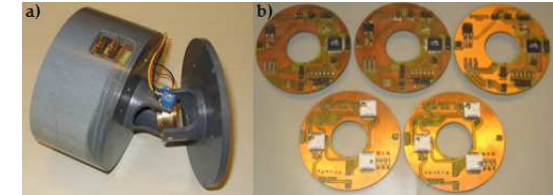
Figure 5: A segment of the snake. (a) Mechanically as- sembled snake segment. (b) Front and back of the electronic circuit boards for the 5 seg- ments.